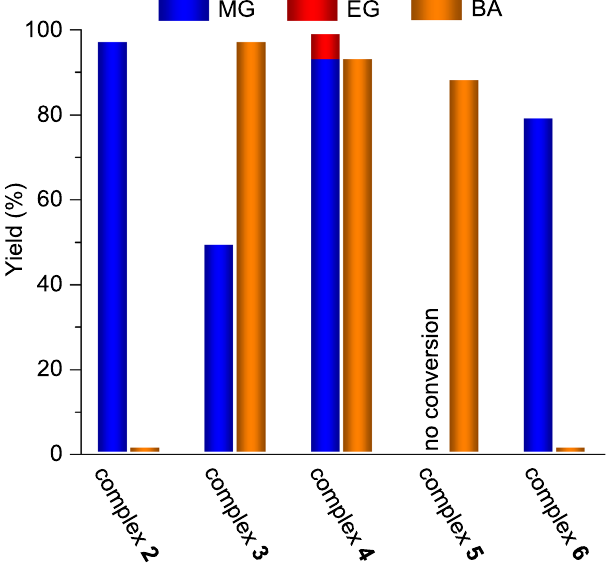
Figure 5. Catalytic performance of complexes 2–6 for hydrogenation of DMO into MG (and/or EG) and that of MB into BA. Reaction conditions: 7.57 mmol ester, 0.5 mol% ruthenium, 5 mol% (for DMO) or 10 mol% (for MB) NaOMe, 10 mL THF, 50 bar H 2 , 100 °C, 4 h. Decarbonylation occurred in DMO hydrogenation when using 0.5 mol% 3 and 10 mol%